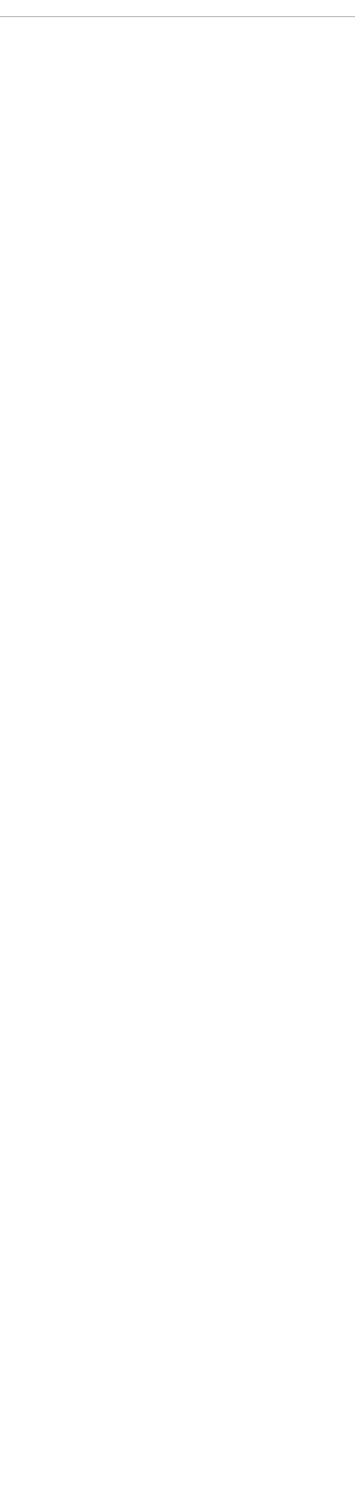
FIGURE 2 The detected gene expressions illustrated in petal diagram and new transcripts found in the transcriptomes of CC and AACC. (A) Petal diagram of gene expression number.The number in petal core represents the number of co-expressed genes in all samples, and the number in each petal represents the number of speci fi cally expressed genes in each sample. Each petal number is separately added to the core number to indicate the number of gene expressions detected in each sample. (B) Gene ontology (GO) classi fi cation of the novel transcripts. (C) Features of the new transcript enriched by the Kyoto Encyclopaedia of Genes and Genomes